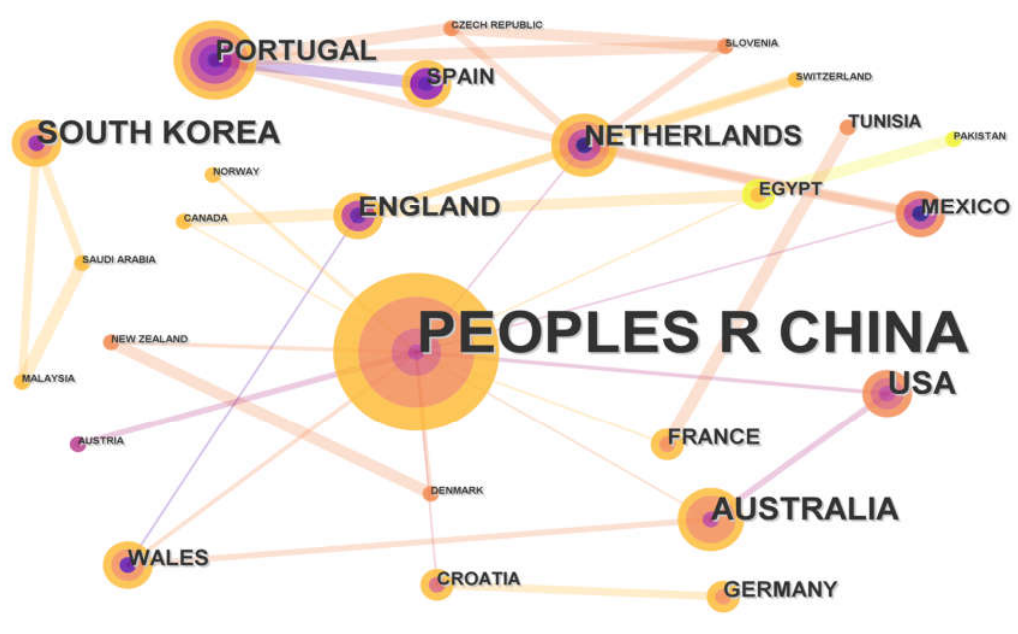
Figure 3. Cooperation networks for countries in the field of micro(nano)plastic toxicity to earth- worms.